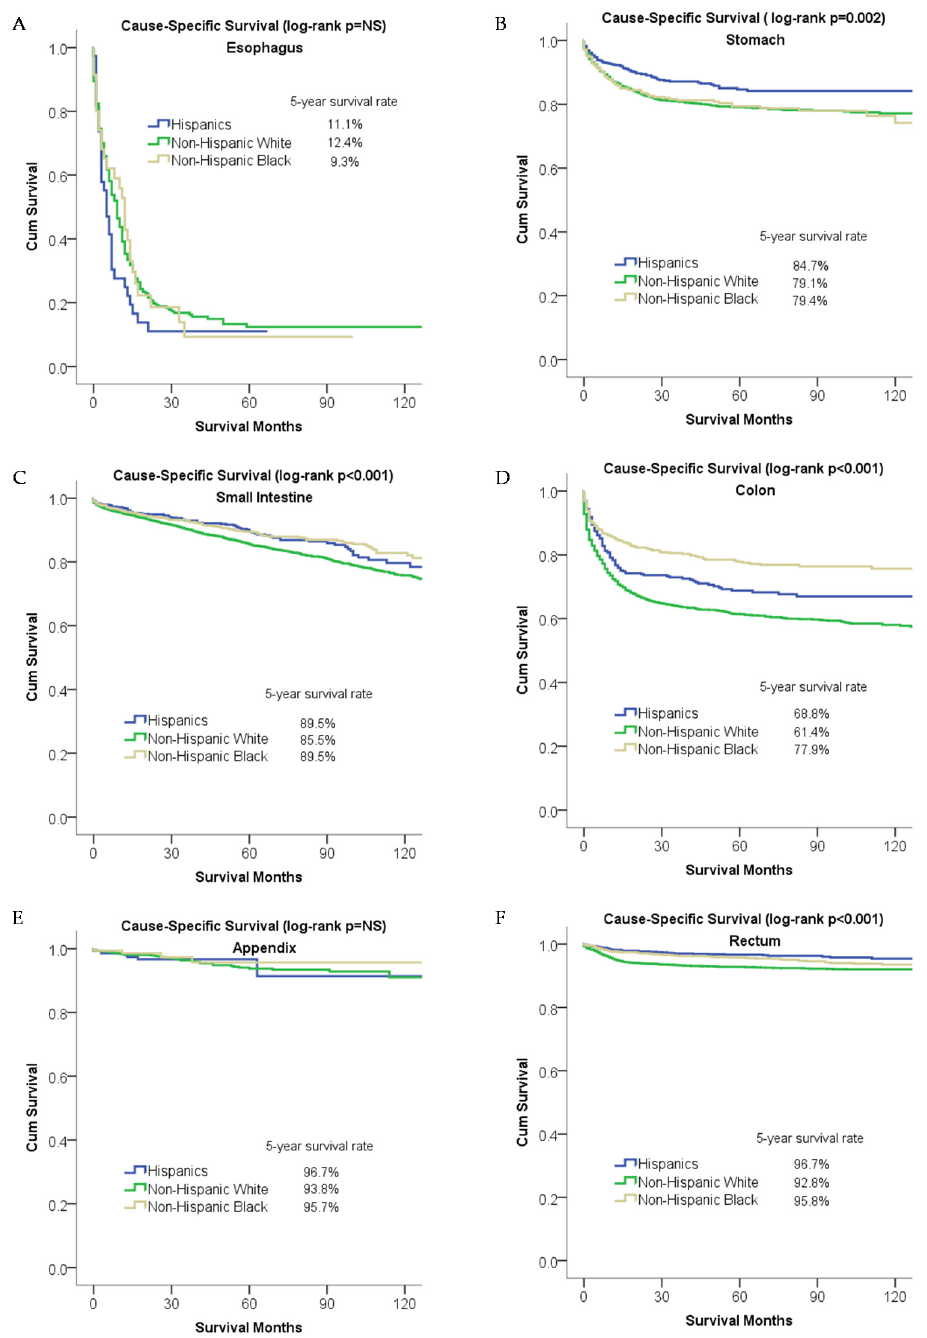
Figure 4. Racial disparities in cause-specific survival for patients stratified by primary site: ( A ) esophagus, ( B ) stomach, ( C ) small intestine, ( D ) colon, ( E ) rectum, and ( F )